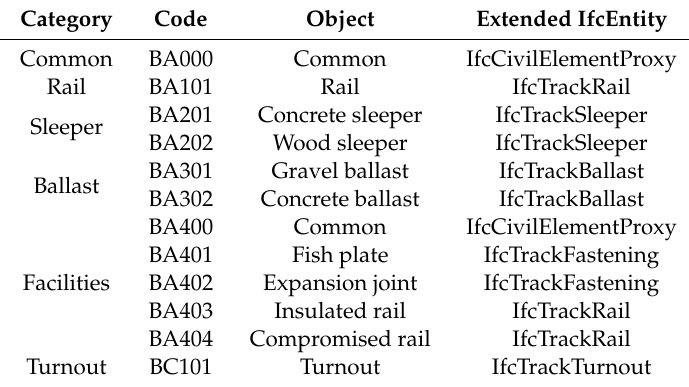
Table 2. Classification system for railway